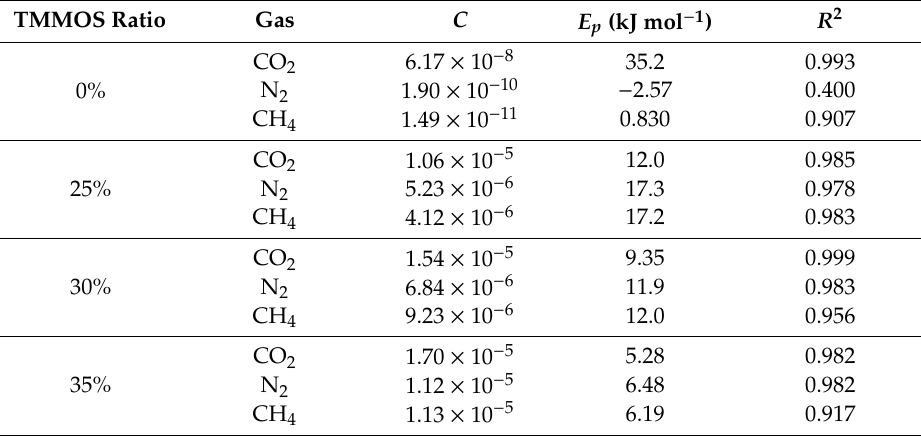
Table 3. Fitting parameter values of the gas translational diffusion model.